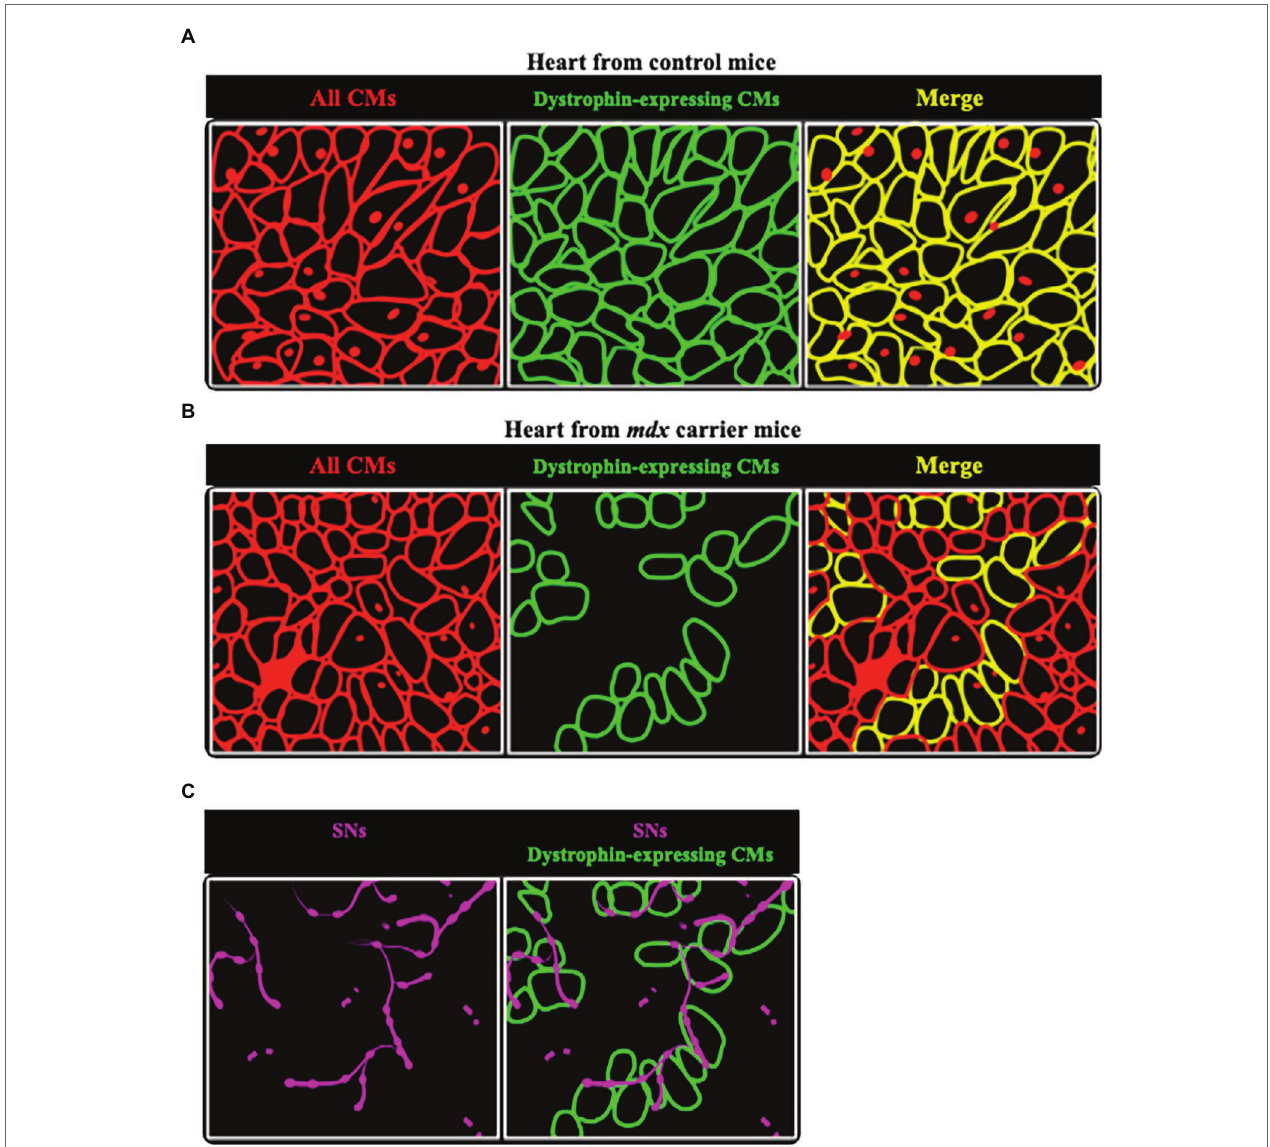
FIGURE 9 | Sympathetic neurons are found selectively in dystrophin-positive areas in hearts from female mdx carrier mice. (A,B) Representative cartoons showing the comparison between hearts from normal (A) and mdx carrier (B) female mice. While in the former dystrophin is homogeneously expressed by all CMs (identified by red lines), in hearts from mdx carriers clusters of dystrophin positive cells (identified by green lines) are intermingled with others lacking dystrophin. (C) Areas occupied by dystrophin negative CMs are less innervated, as compared to the positive ones, with neuronal processes (in purple) appear